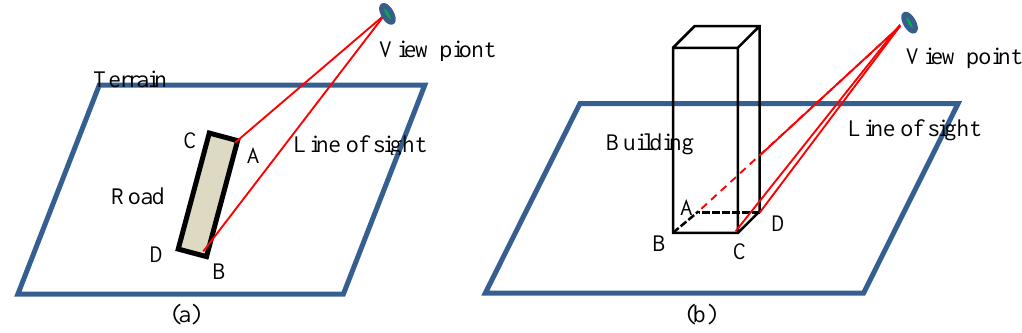
Figure 4. Visibility analysis for a road and building. ( a ) If segment AB is visible from the viewpoint, the whole road ABCD is visible; and ( b ) similarly, if the segments AD and DC are visible from the viewpoint, the building is visible.